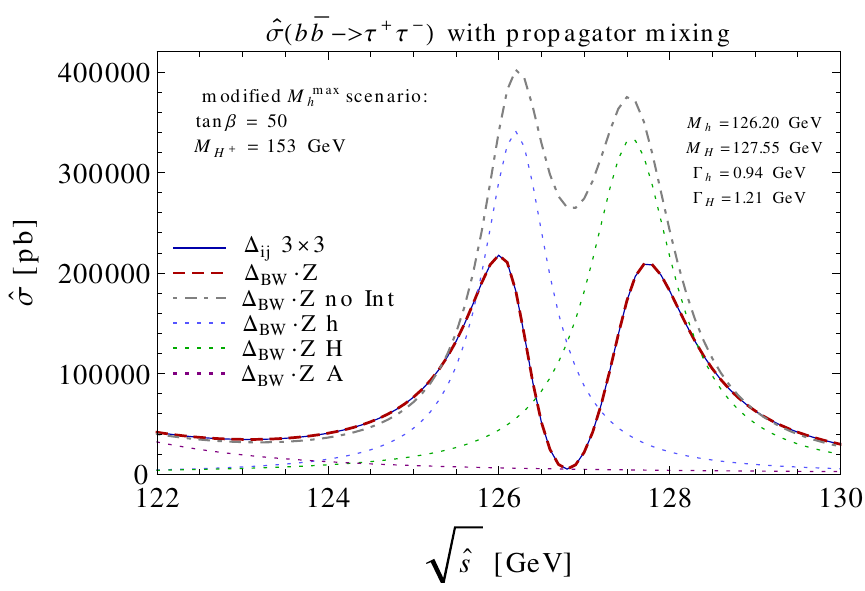
Figure 11 . The partonic cross section ^ (cid:27) ( bb ! (cid:28) + (cid:28) (cid:0) ) in a modi(cid:12)ed M max and M = 153 GeV. The cross section is calculated with the full mixing propagators (blue, H (cid:6) solid), approximated by the coherent sum of Breit-Wigner propagators times ^ Z -factors with the interference term (red, dashed) and the incoherent sum without the interference term (grey, dot- dashed). The individual contributions mediated by h 1 (light blue), h 2 (green) and h 3 (purple) are shown as dotted